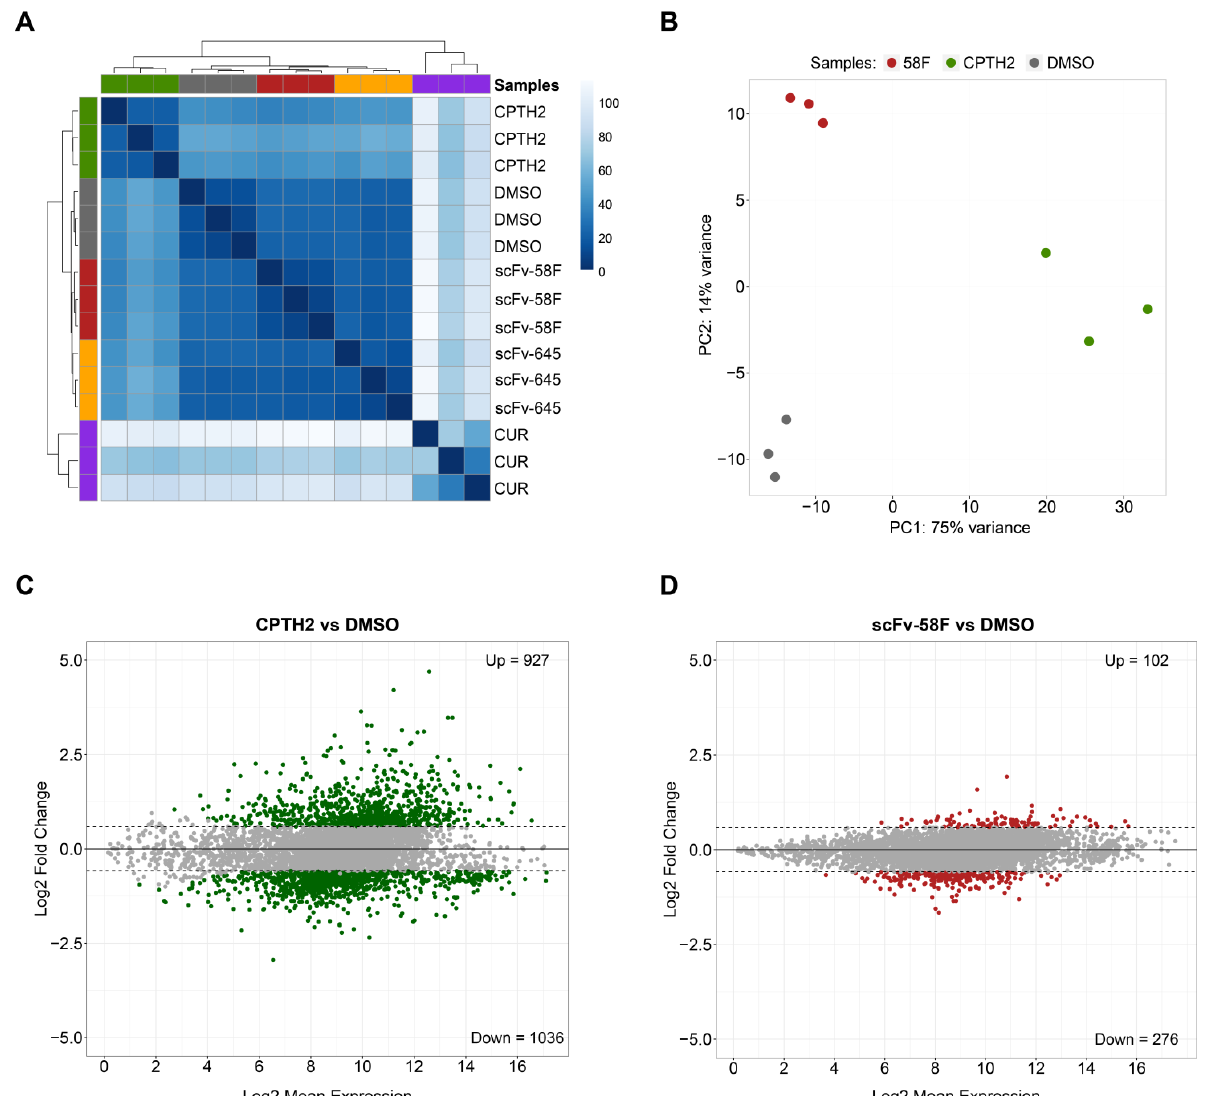
Figure 1. Expression of scFV-58F intrabody induces fewer transcriptional changes than treatment with HAT inhibitors. ( A ) Hierarchical clustering of RNAseq data from three biological replicates for each analyzed condition in yeast cells (CUR = curcumin-treated cells, CPTH2 = CPTH2-treated cells, DMSO = DMSO-treated cells, 58F = cells expressing scFv-58F, 645 = cells expressing scFv-645) ( B ) Principal Component Analysis (PCA) of the RNAseq data from three experimental conditions 58F, CPTH2, and DMSO (negative control). For clarity, Curcumin-treated samples (which account for most of the variation) and the scFv-645 samples were omitted in this PCA plot and are reported in Supplementary Figure S2A. Among the remaining nine samples, the principal component of